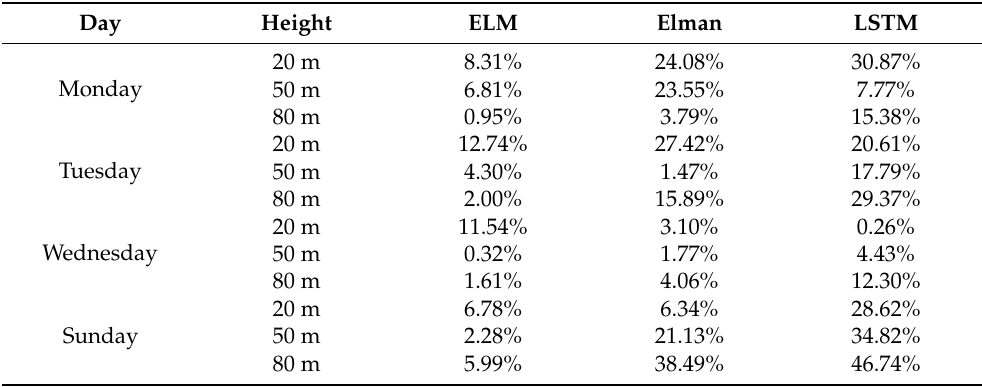
Table 7. Improvement percentages of the ELM–Elman–LSTM model. Day Height ELM